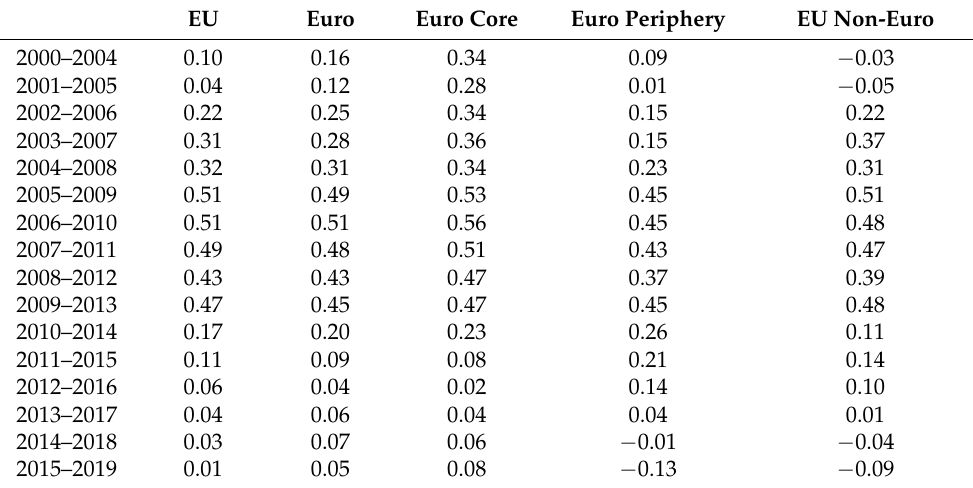
Table 5. Youth unemployment rate growth—averages of country-level correlation coefficients for different country groups. EU Euro Euro Core Euro Periphery EU